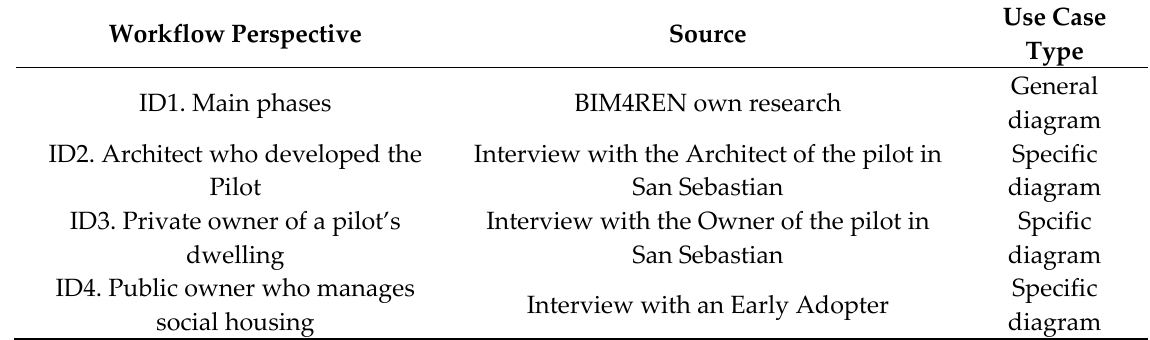
Table 1. Façade renovation Use Case identified during BIM4REN interviews.